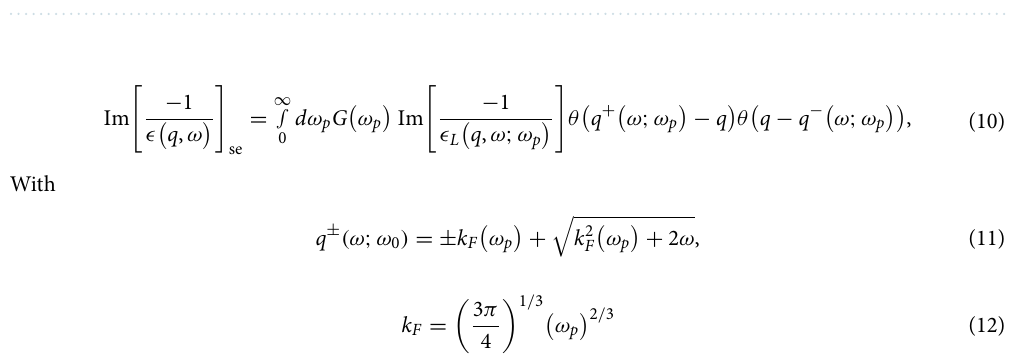
Figure 2. Perspective view of the energy loss function as a function of momentum transfer and energy loss calculated by the FPA for